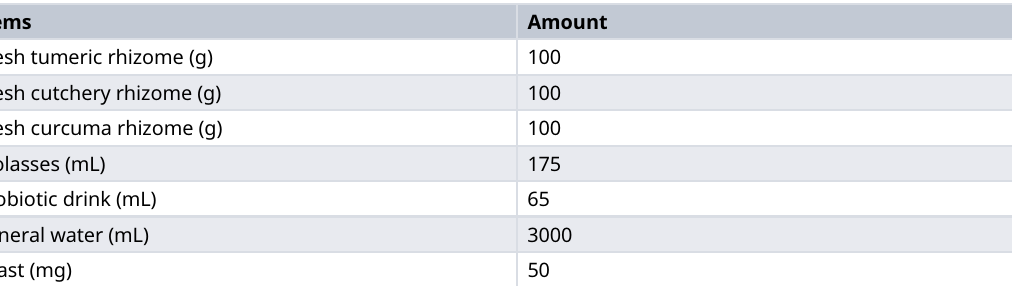
Table 1. Composition of medicinal herb